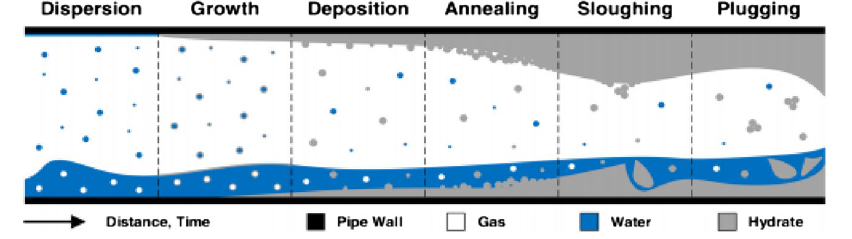
Figure 1. Growth of the hydrates in gas-dominant multiphase systems 8 .